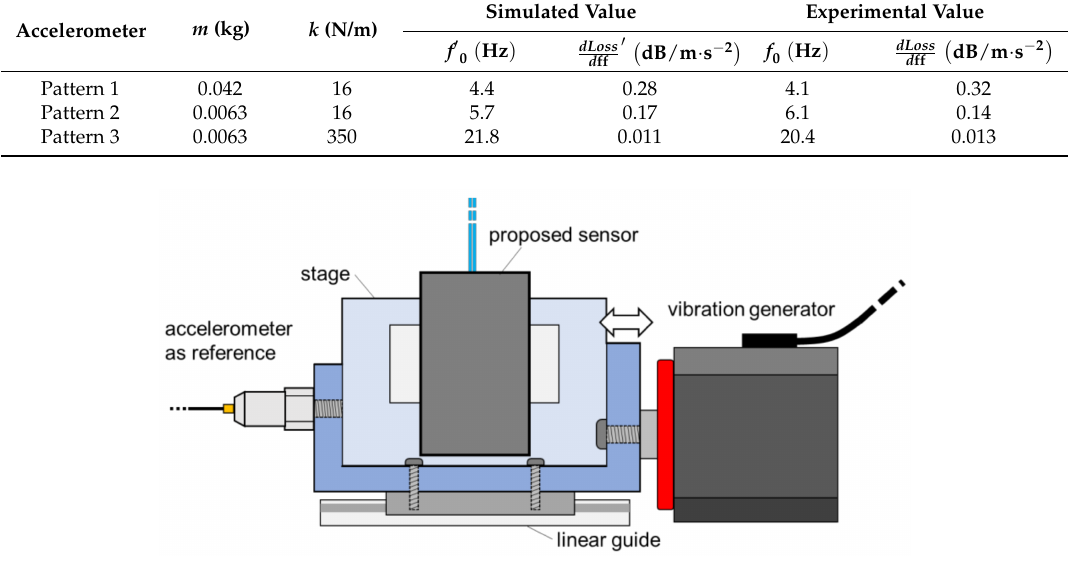
Figure 5. Experimental setup for frequency response characteristics of the proposed accelerometer.